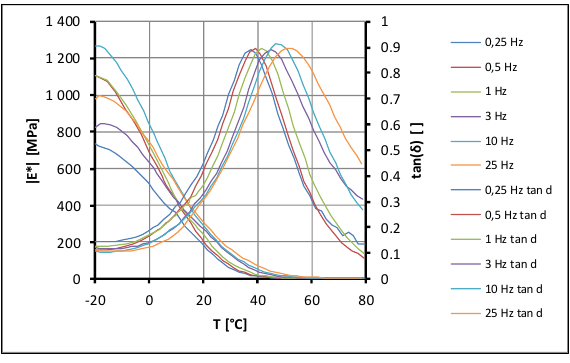
Fig. 15 Results of the DMTA tests.